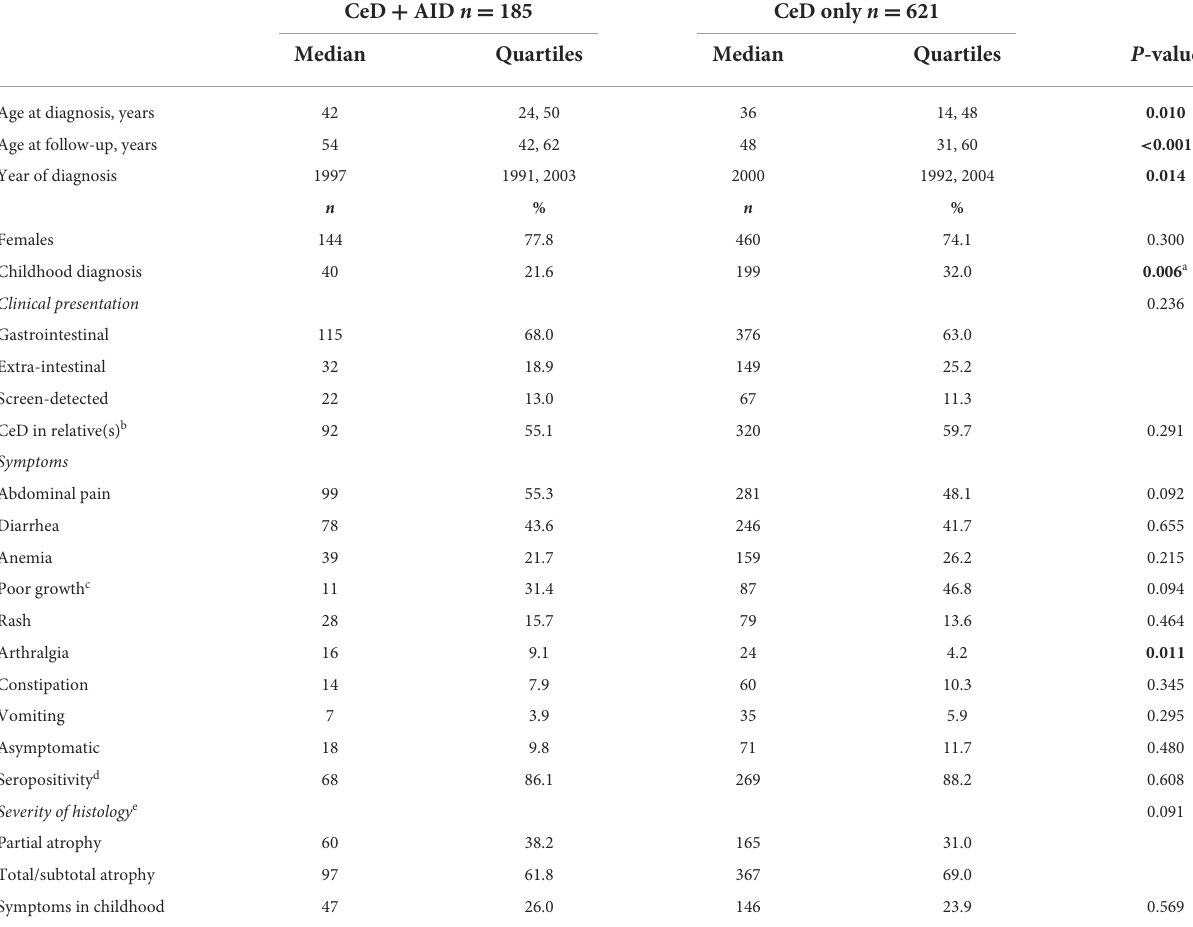
TABLE 1 Demographic data and clinical and histological characteristics at celiac disease (CeD) diagnosis in 806 patients with or without coexisting autoimmune disease (AID). CeD + AID n = 185 CeD only n = 621 Median Quartiles Median